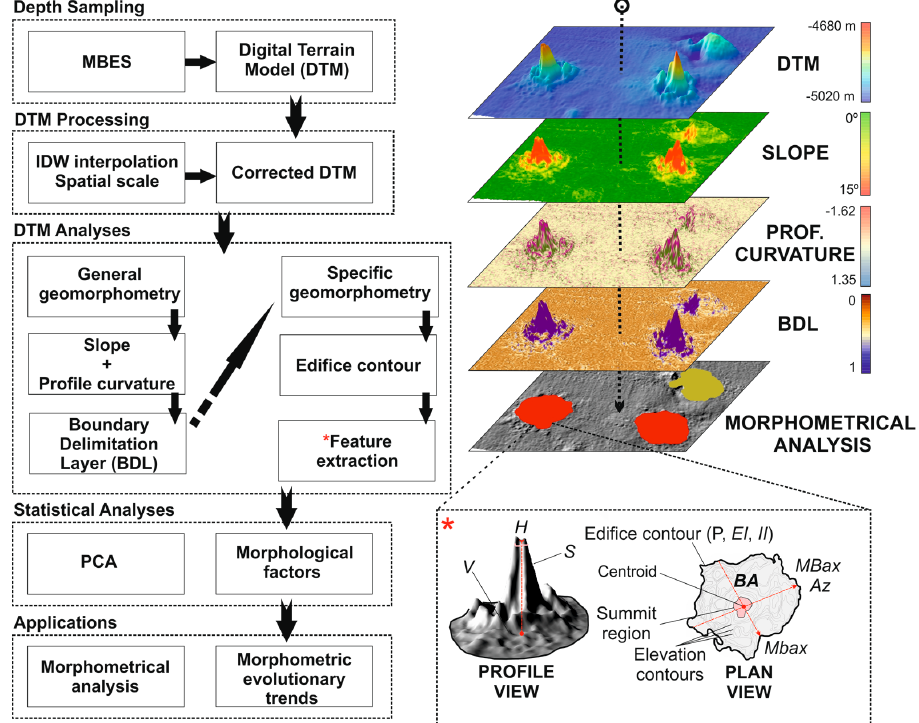
Figure 2. Methodological workflow for the acquisition, processing, analyses, and applications of DEM in this study. The main features extracted are listed as follows: H (m) height; S (degrees) slope; V (km 3 ) volume; BA (km 2 ) basal area; P (km) perimeter; EI—ellipticity index; II—irregularity index; MBax and mBax (km) major and minor basal axes and Az (degrees) azimuth.